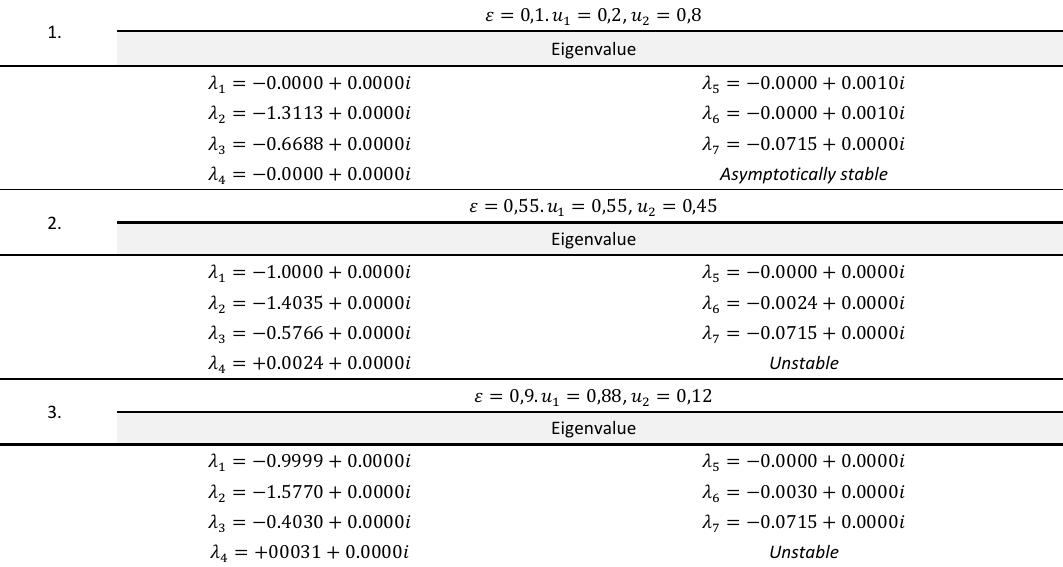
Table 4: The eigenvalues of the endemic equilibrium point